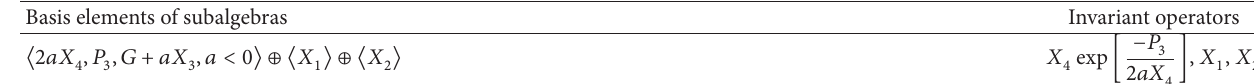
Table 2: Invariant operators of subalgebras of the type 𝐴 3,2 ⊕ 𝐴 1 ⊕ 𝐴 1 .